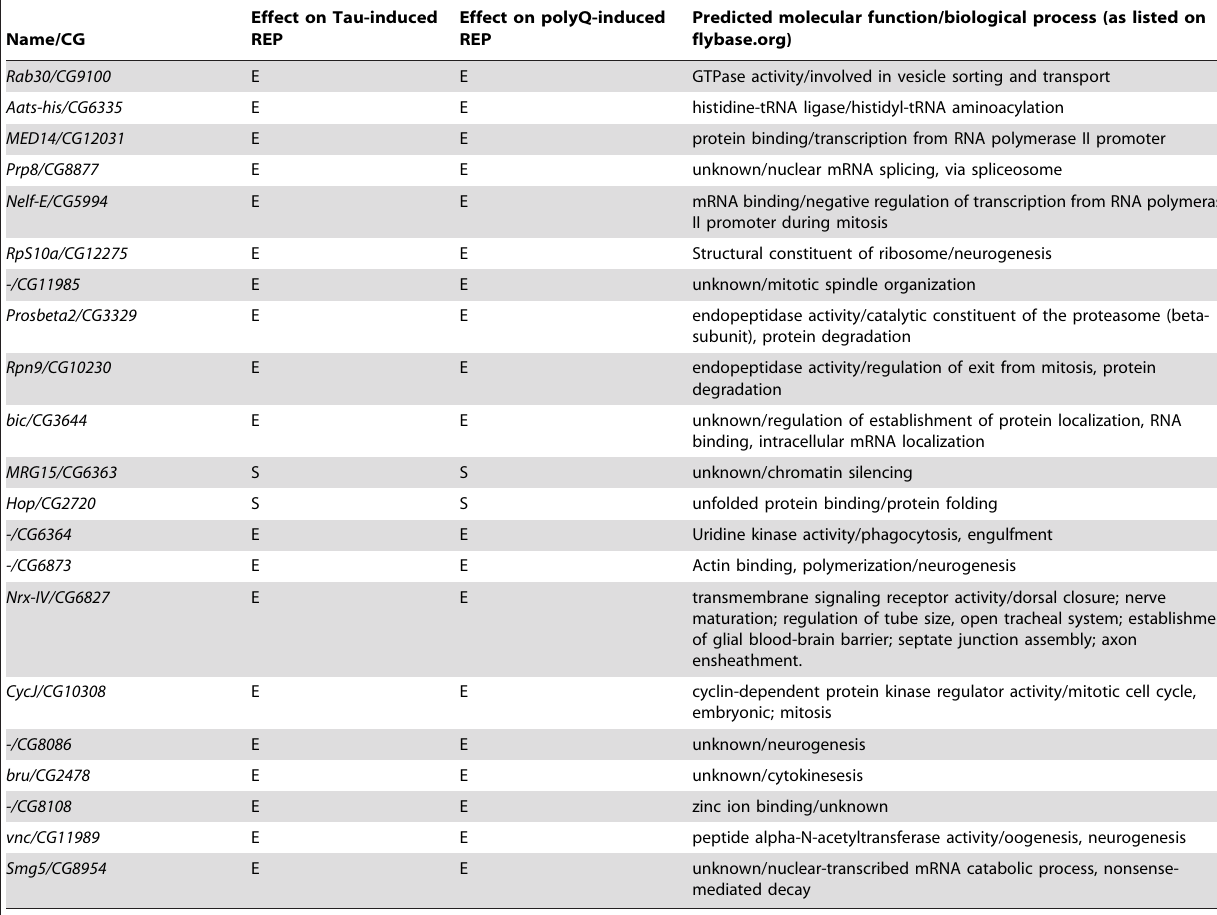
Table lists gene name (if applicable) and gene ID of all candidates identified to have a similar effect on polyQ- and Tau-induced REPs. Mode of modification is indicated (enhancement (E), suppression (S)). A brief summary of the molecular and biological functions assigned to the identified gene products is